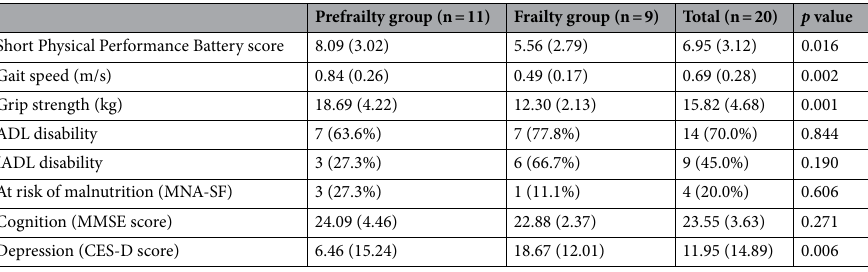
Table 2. Geriatric parameters by frailty status. Values are presented as mean ± standard deviation or number (%). MMSE Mini-Mental State Examination, CES-D Center for Epidemiological Studies Depression Scale,